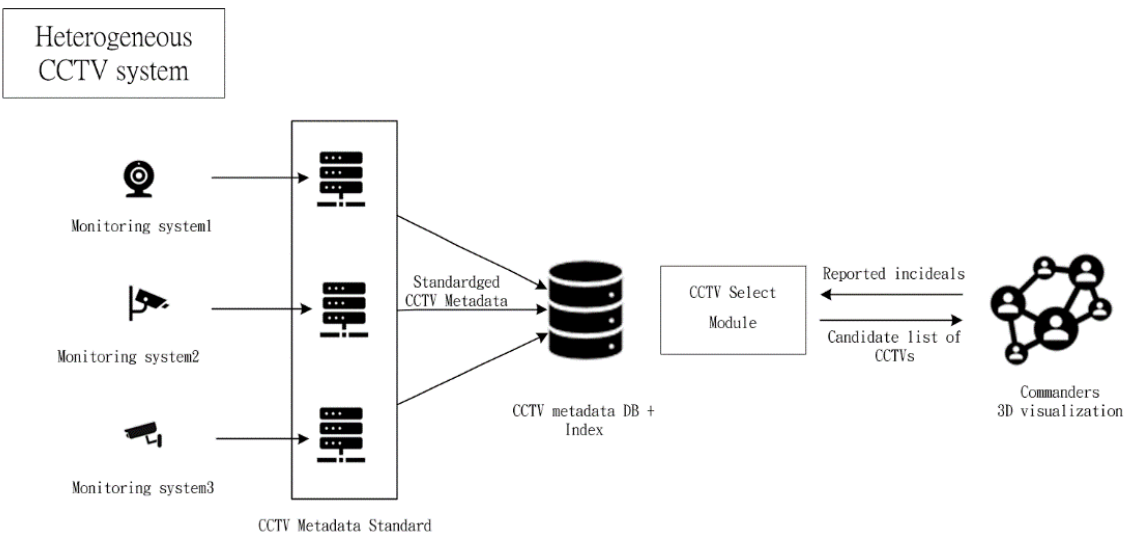
Figure 1. Sharing framework of metadata-driven heterogeneous CCTV systems.